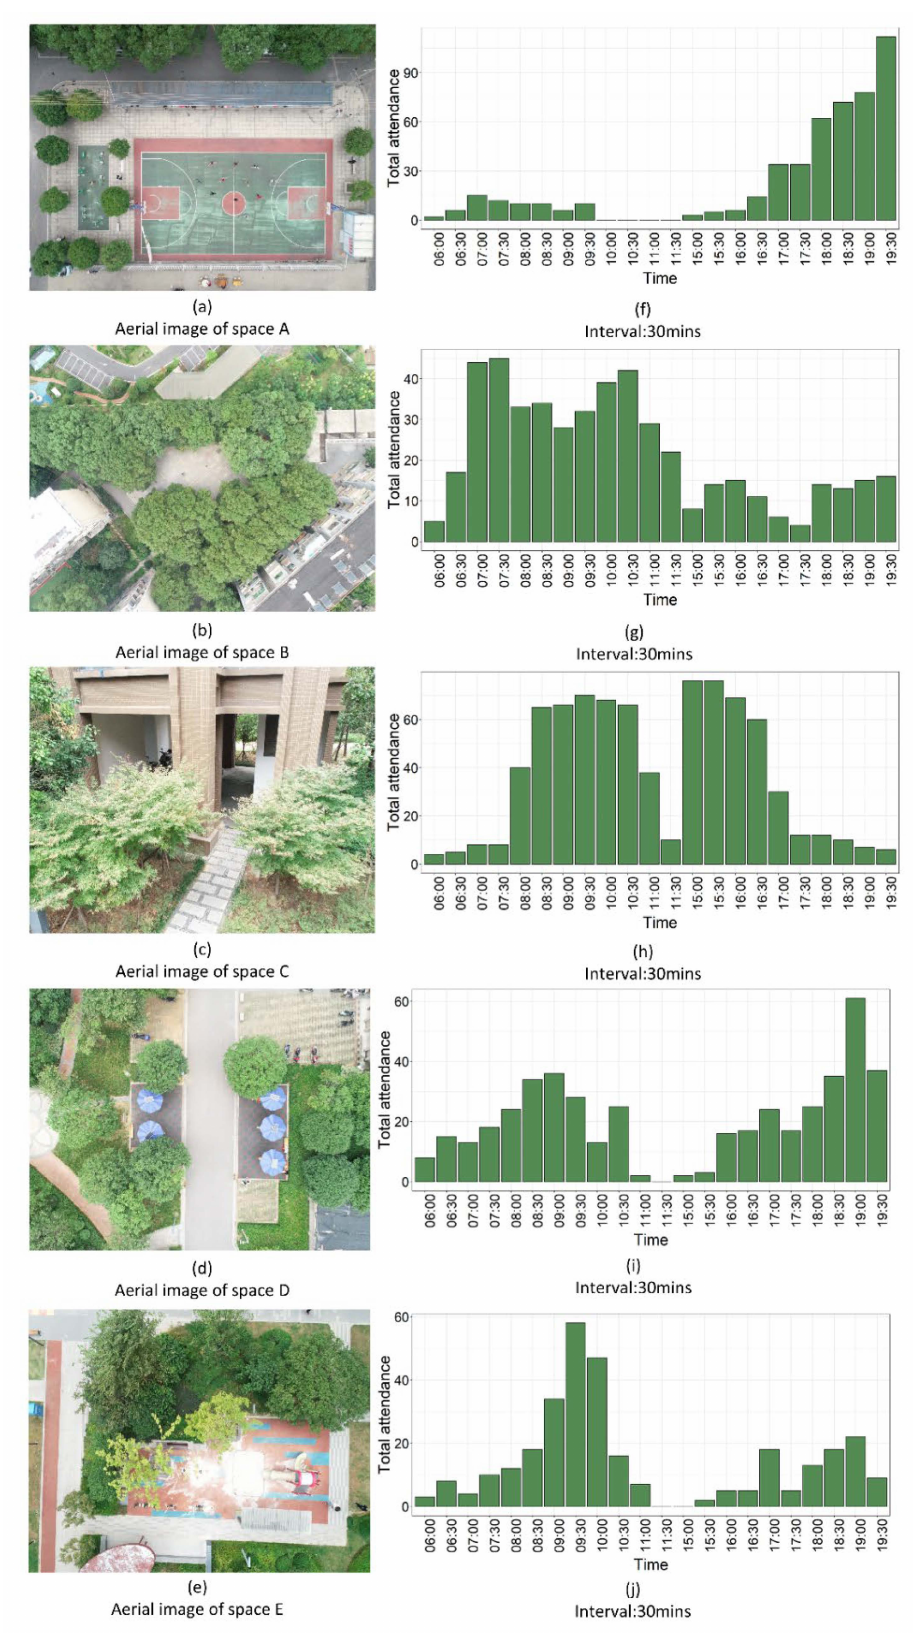
Figure 11. Spatial and temporal distribution of